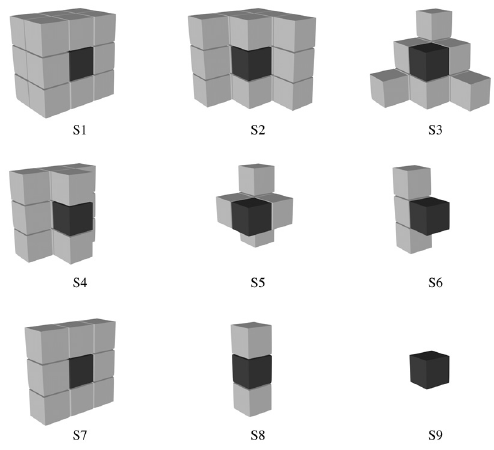
Figure 14. The nine unique surface voxel classes.